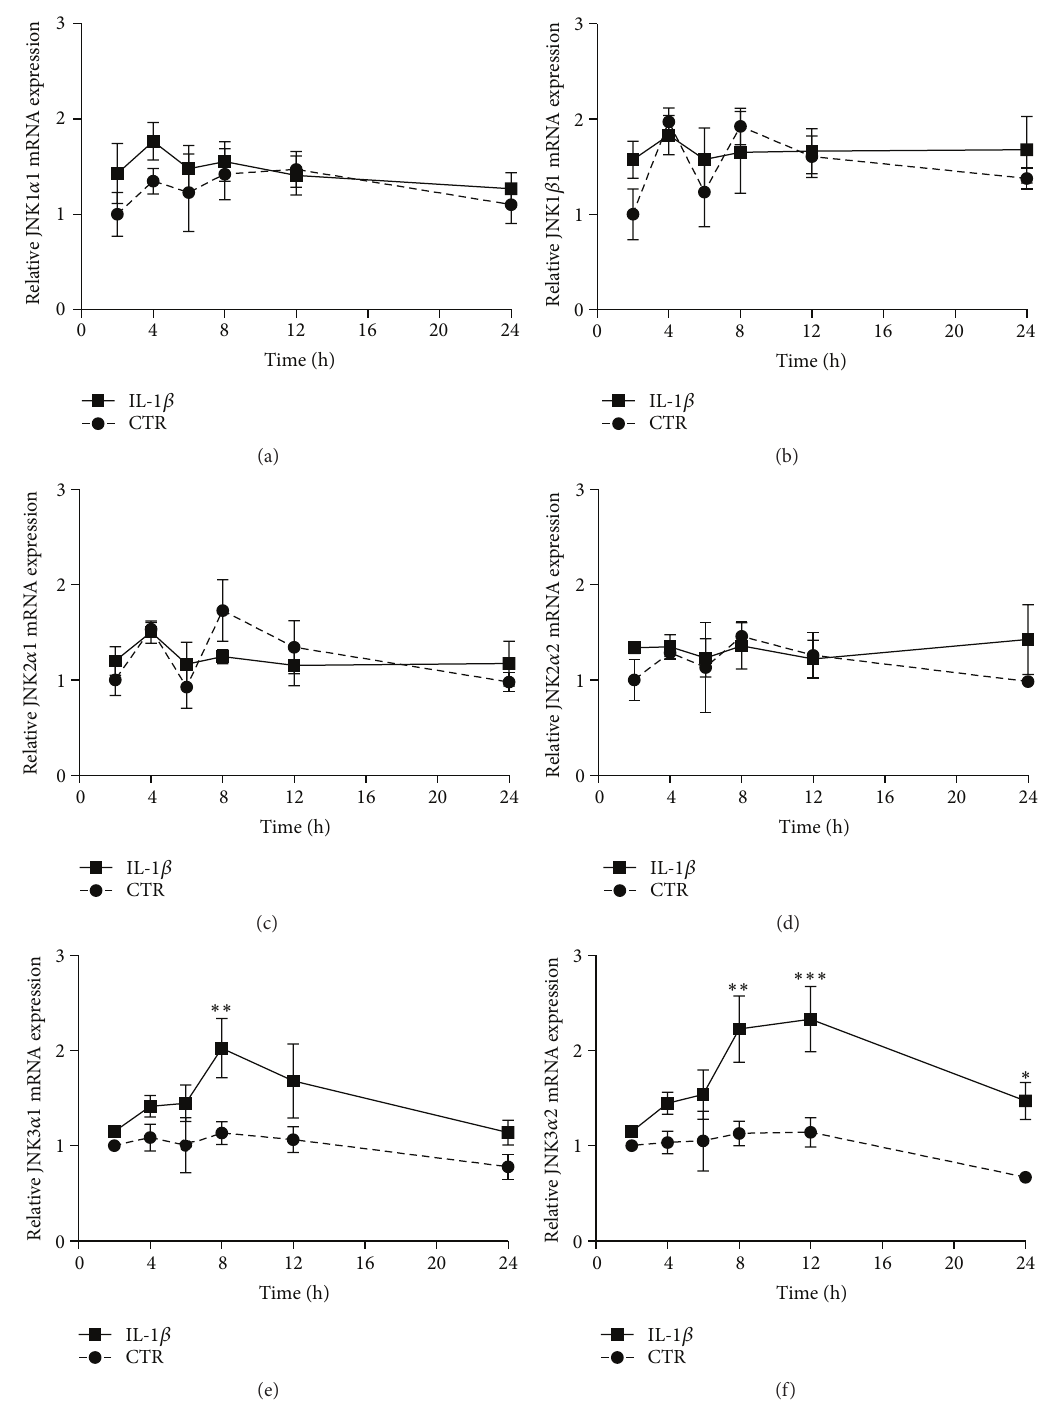
Figure 1: JNK isoform expression in INS-1 cell. INS-1 cells were exposed to 150pg/mL IL-1 𝛽 (square) or vehicle (circle) for 2 to 24 h. Relative mRNA of the JNK isoforms was measured using quantitative RT-PCR and normalized to the average of 18S and hprt1. (a) Relative JNK1 𝛼 1 mRNA expression, (b) relative JNK1 𝛽 1 mRNA expression, (c) relative JNK2 𝛼 1 mRNA expression, (d) relative JNK2 𝛽 2 mRNA expression, (e) relative JNK3 𝛼 1 mRNA expression, and (f) relative JNK3 𝛼 2 mRNA expression. Data are means ± SEM of 𝑛 = 4 independent experiments. ∗ 𝑃 < 0.05 , ∗∗ 𝑃 < 0.01 , and ∗∗∗ 𝑃 < 0.001